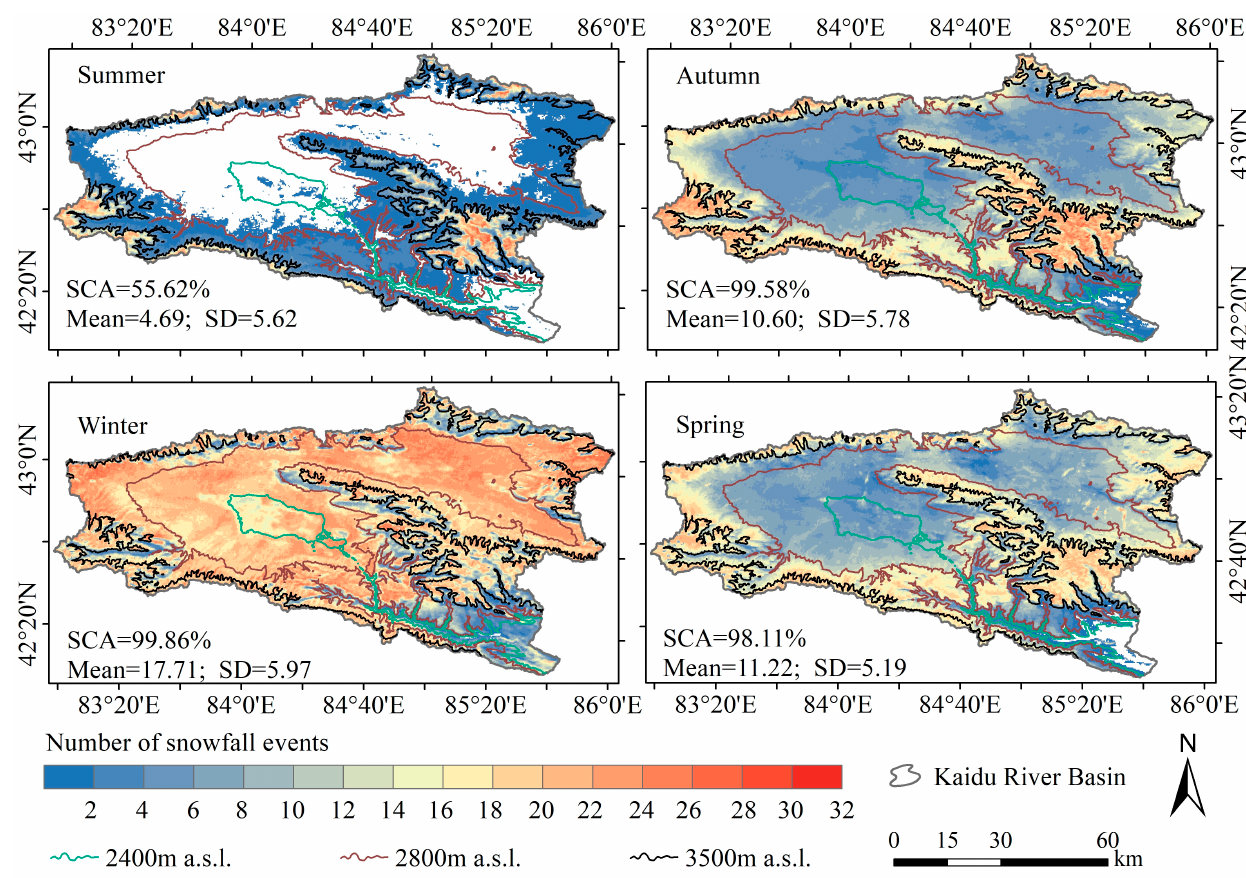
Figure 9. Spatial distribution of the seasonal median frequency of snowfall over the Kaidu River Basin from June 2000 to May 2020. SCA = snow-covered area, Mean = the mean value of the median snowfall frequency, and SD = the standard deviation of the median snowfall frequency.